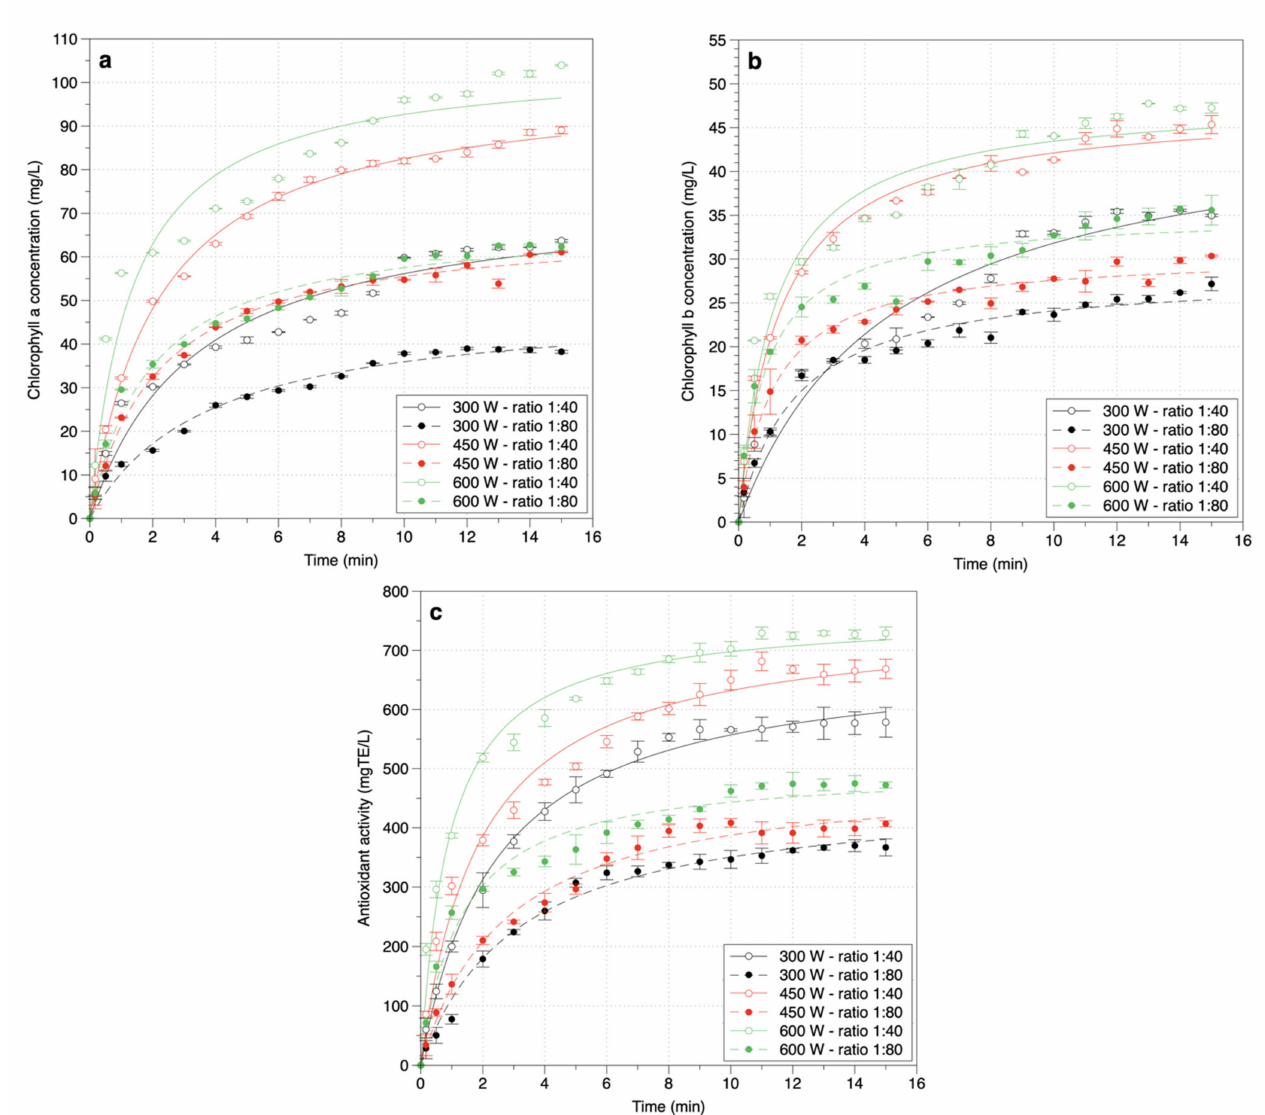
Figure 1. Changes in the concentration of chlorophyll a ( a ), chlorophyll b ( b ), antioxidant activity ( c ) during MAE of P. fruticosa leaves at different microwave power and material/solvent